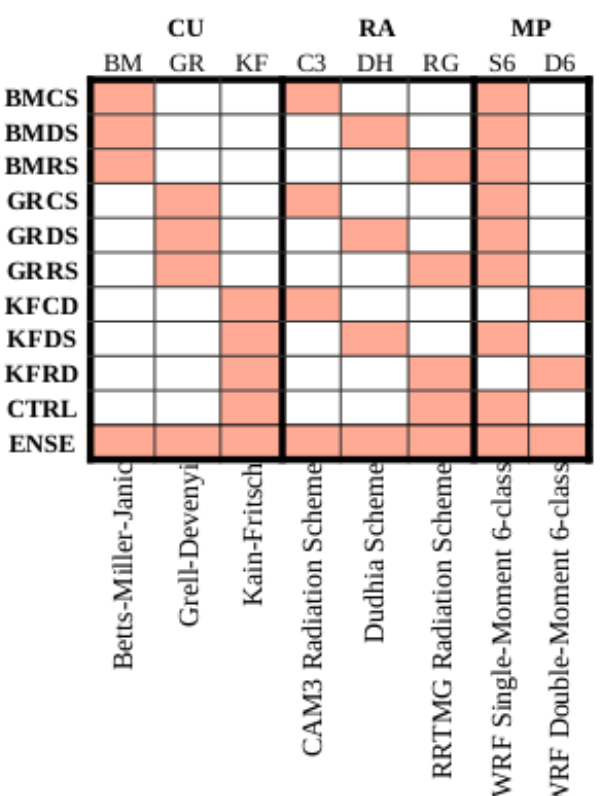
Figure 2. Different model configurations adopted for each experiment for Cumulus parameteriza- tions (CU, columns 1–3), radiation scheme (RA, columns 4–6) and microphysics (MP, columns 7–8). Abbreviations (BMCS, BMDS, BMRS, GRCS, GRDS, GRRS, KFCD, KFDS, KFRD, CTRL = control simulation, and ENSE = ensemble) are described in